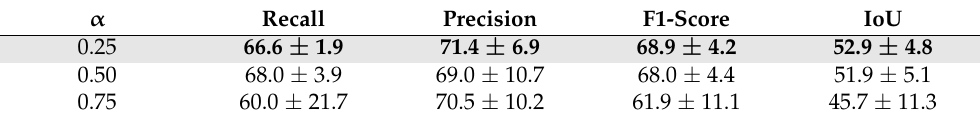
Table 7. Results of analyzing parameter α for fast-SCNN in (%) for the road marking class.